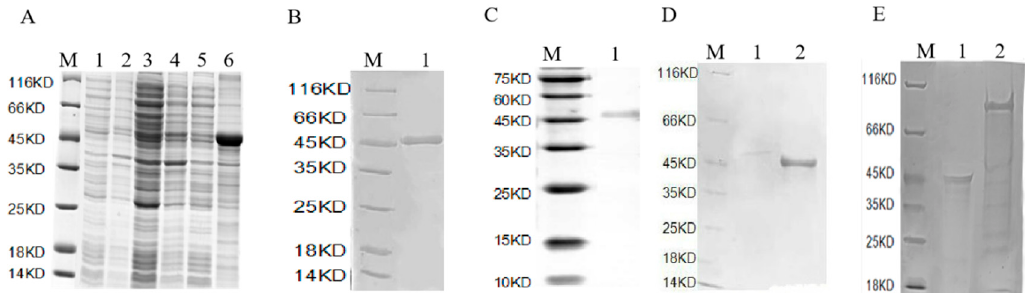
Figure 3. Detection of fusion expressed protein and screening of ThTrx5 interacting proteins